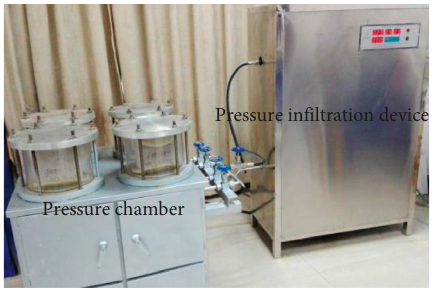
Figure 4: Experimental devices. Table 4: Working conditions of the